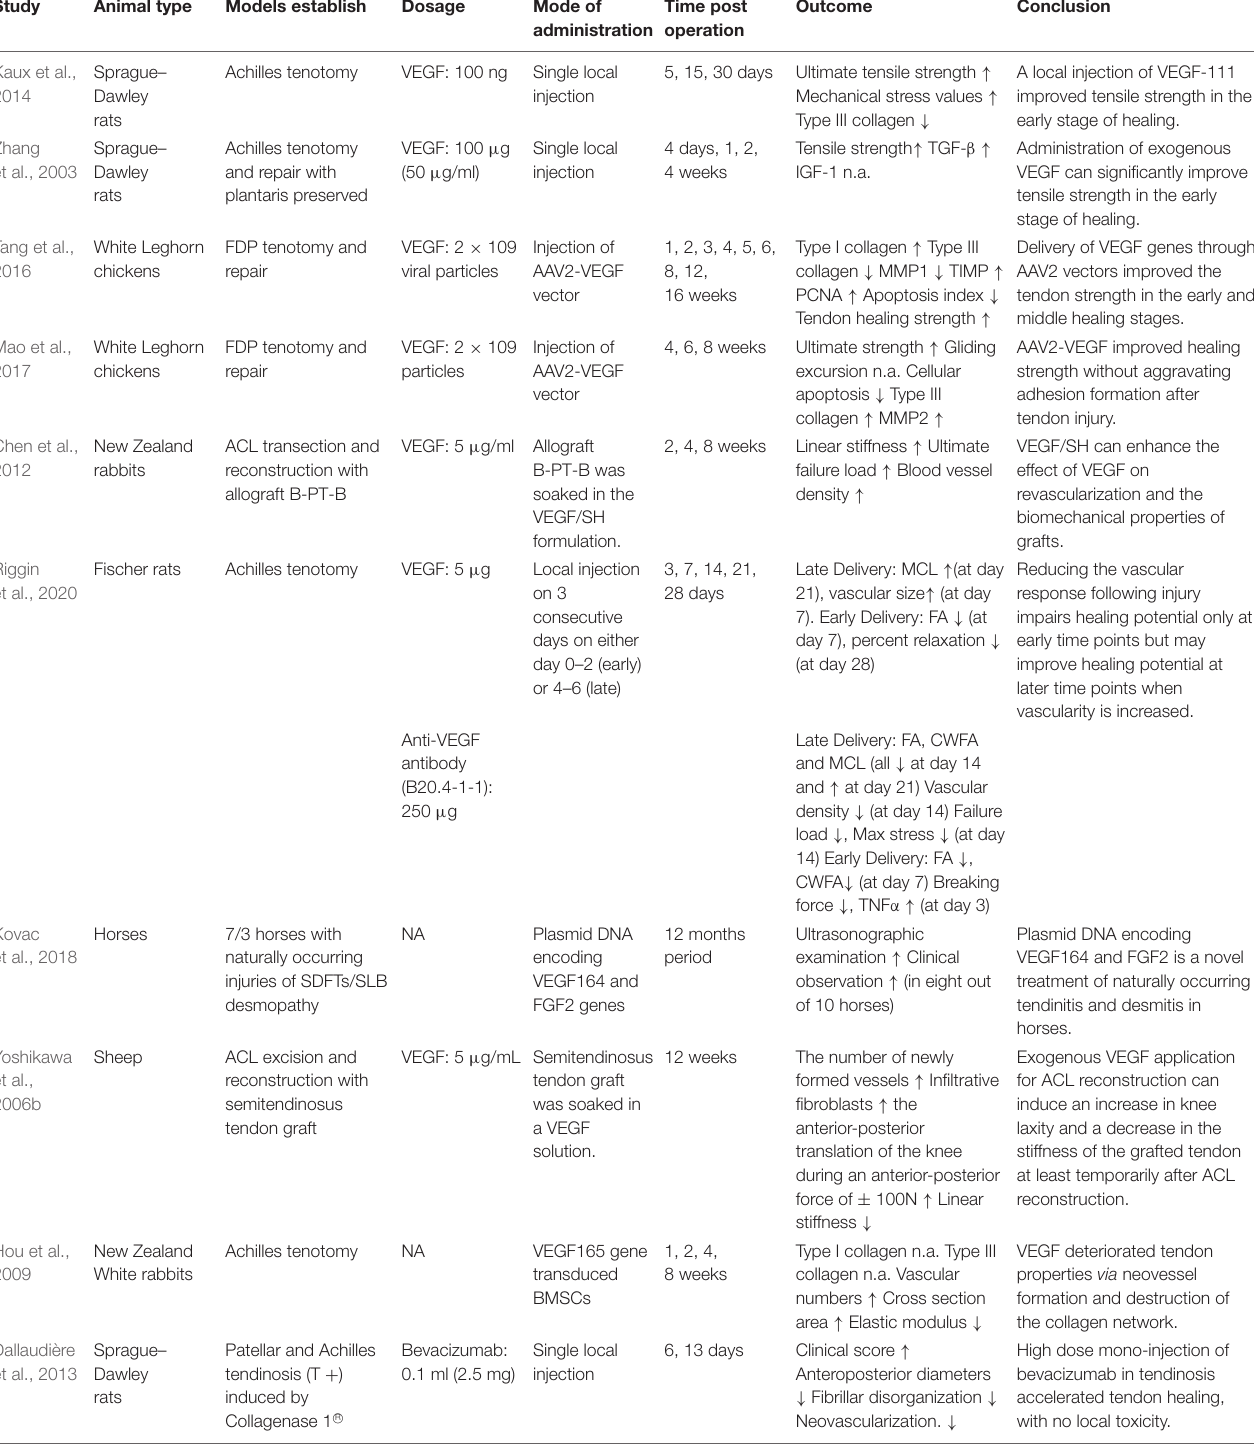
TABLE 1 | Summary of results and characteristics of the studies which investigated the effects of exogenous VEGF (or VEGF inhibitor) in tendon